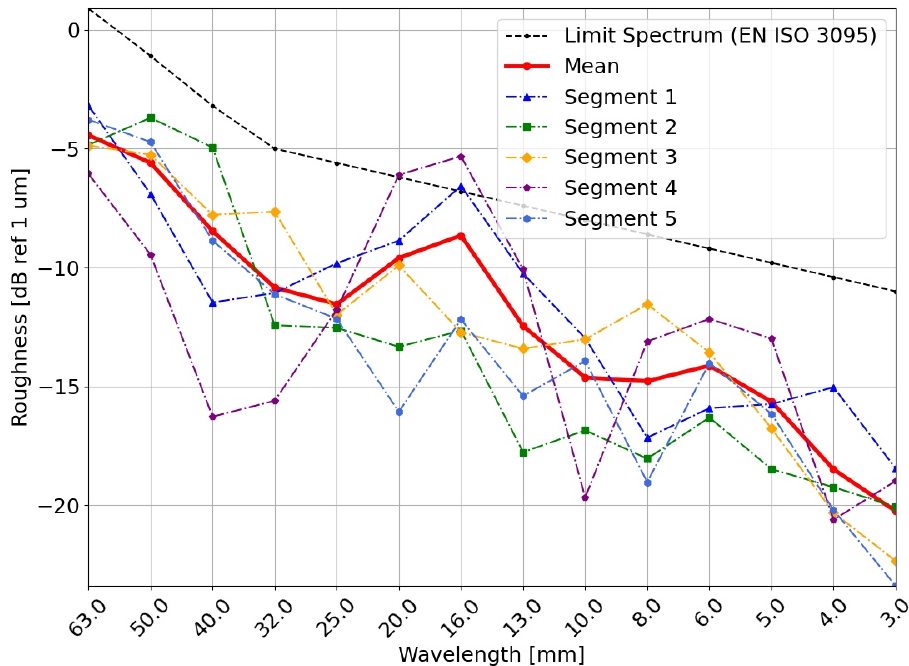
Figure A1. Spectrum of acoustic roughness for stylus 2 and reference section A (Mean), the five segments measured by SBB and the limit spectrum from EN ISO 3095 [22].